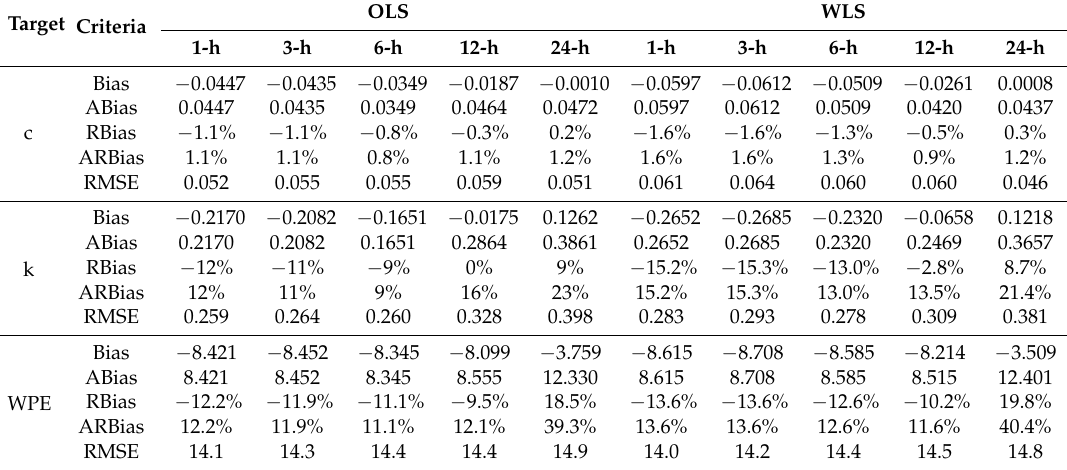
Table 6. Bias, absolute bias, relative bias, and absolute relative bias of the parameter estimates and wind potential energy for the different cases. The presented Bias, ABias, RBias and ARBias values are the mean values for three employed stations. The case indicates the temporal scale of the wind speed data used to obtain the parameters of the Weibull distribution for the 10-min mean wind speed